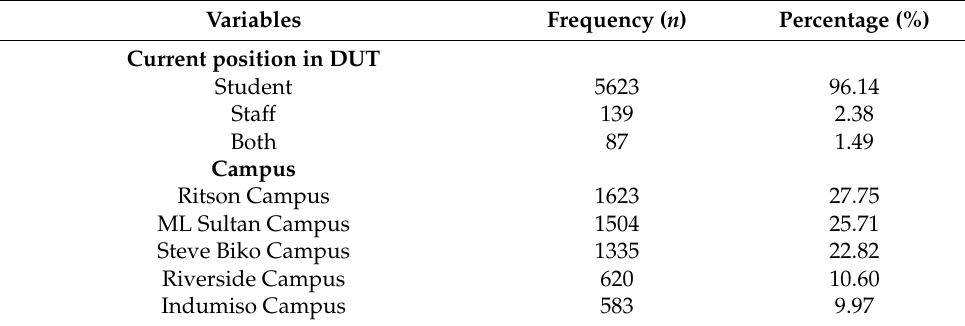
Table 2. Position in DUT of participants ( n =